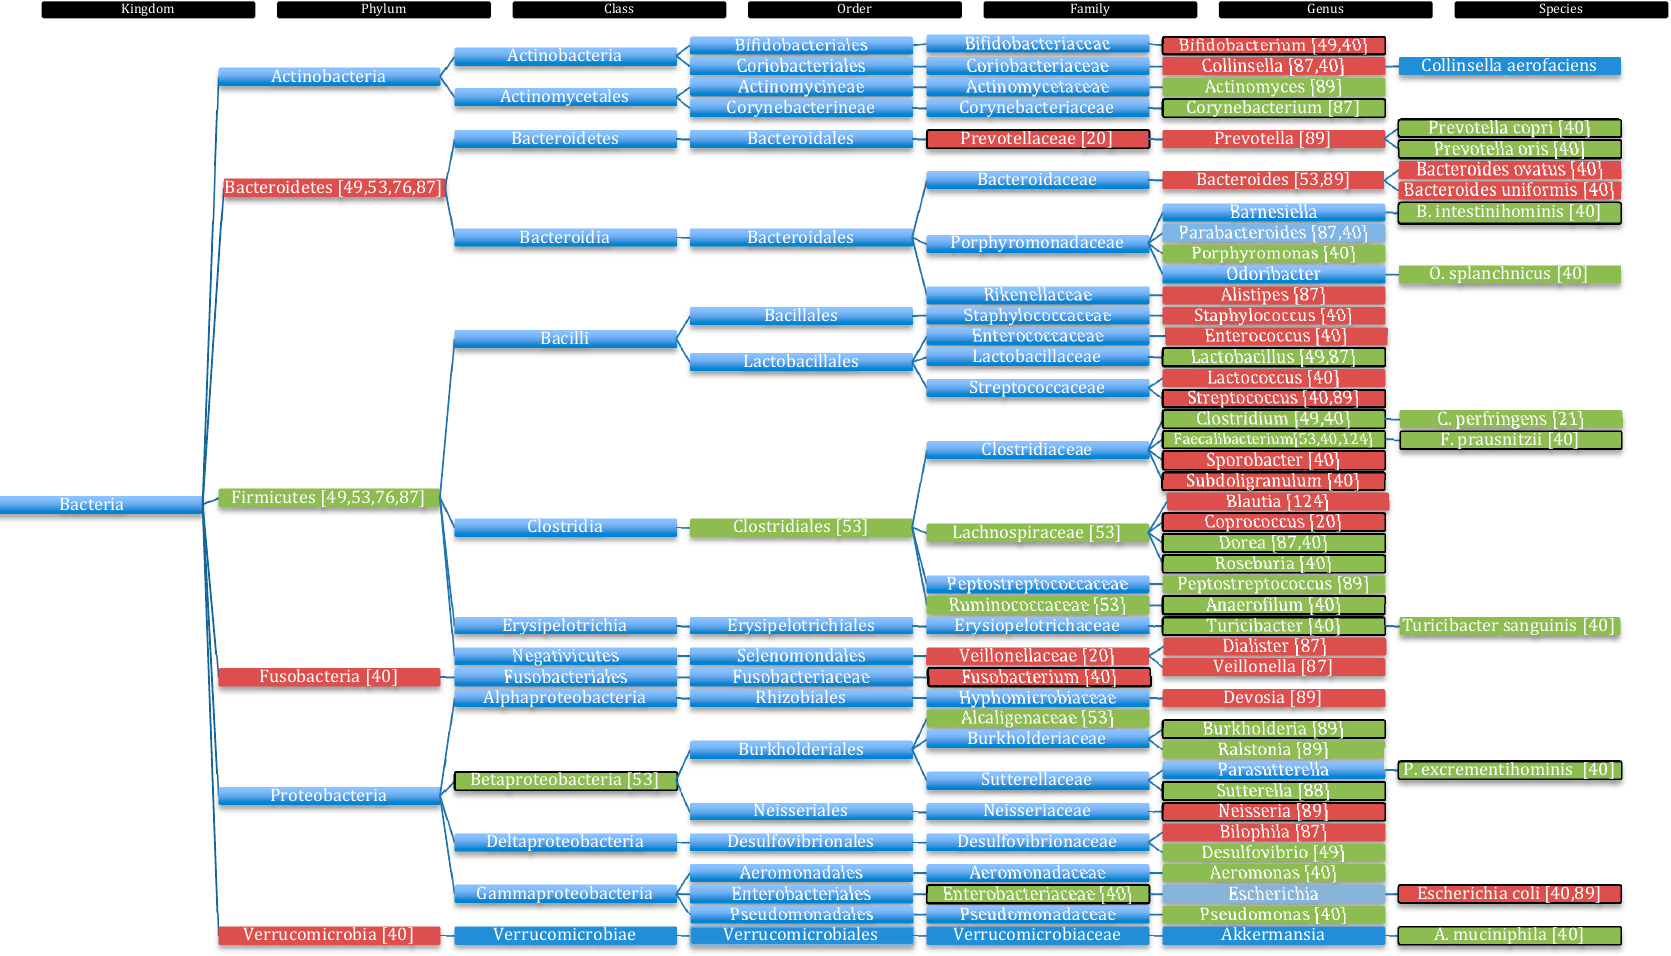
Figure 3. Taxonomic classification of dysbiotic bacteria found in autistic individuals. All bacterial taxa mentioned within this chapter are found in this figure. Green indicates elevated taxa in the gut microbiota of ASD individuals. Red indicates decreased taxa in the gut microbiota ASD individuals. Additionally, black surrounded boxes show significant results in at least one study. Significance levels are taken from the original